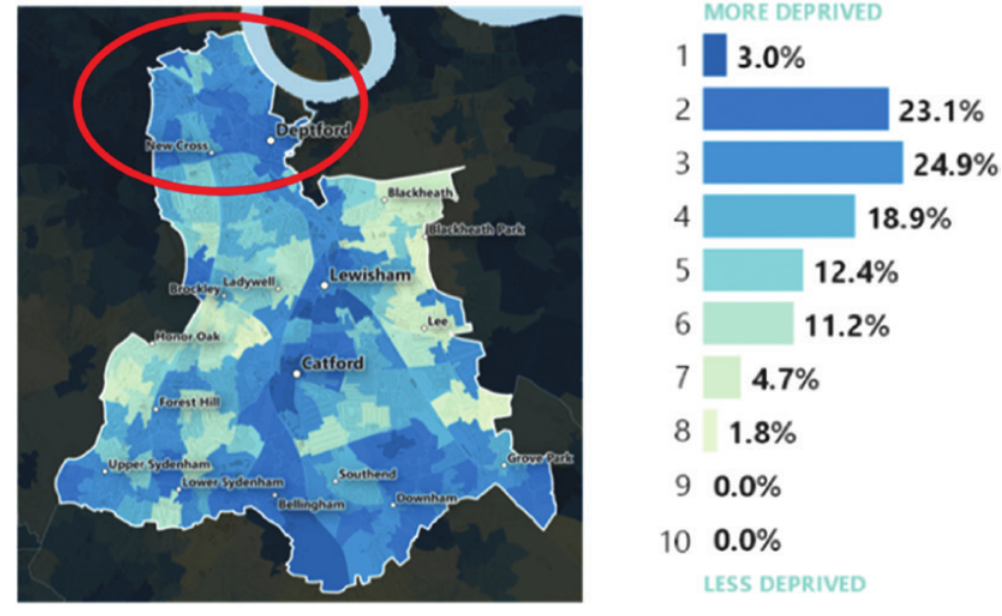
figure 6: Data from Indices of Multiple Deprivation in england (MhclG, 2019) mapped on to a map of the london Borough of lewisham showing poverty in deciles, with darkest blue representing the greatest poverty (map created from IMD 2019 data by alistair Rae, University of sheffield (Rae,